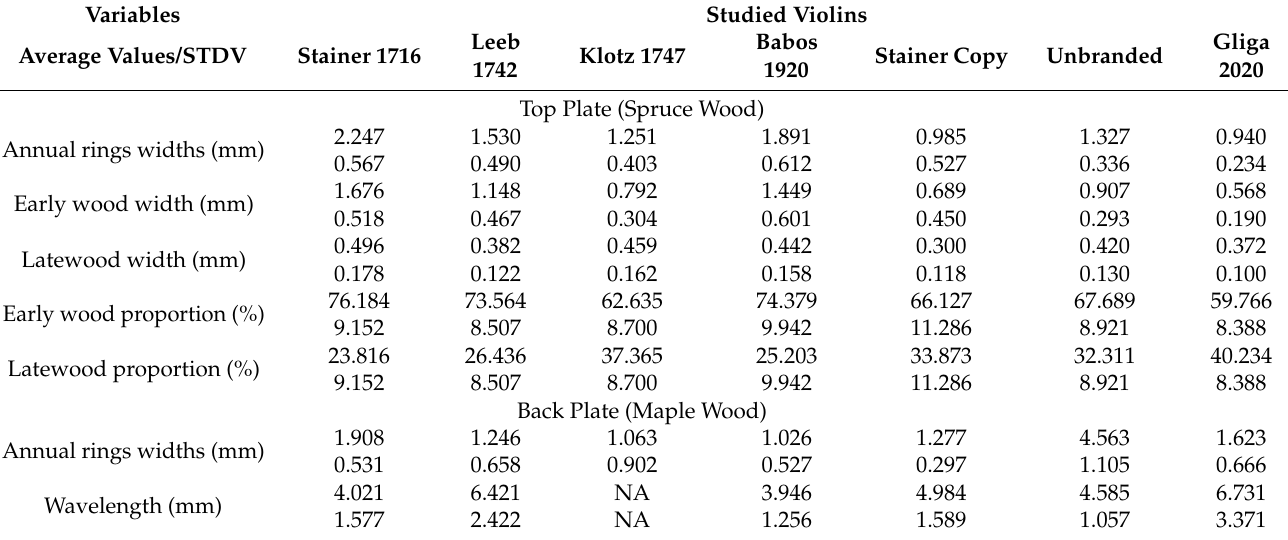
Table 1. The anatomical features of spruce and maple wood from top and back plates of studied